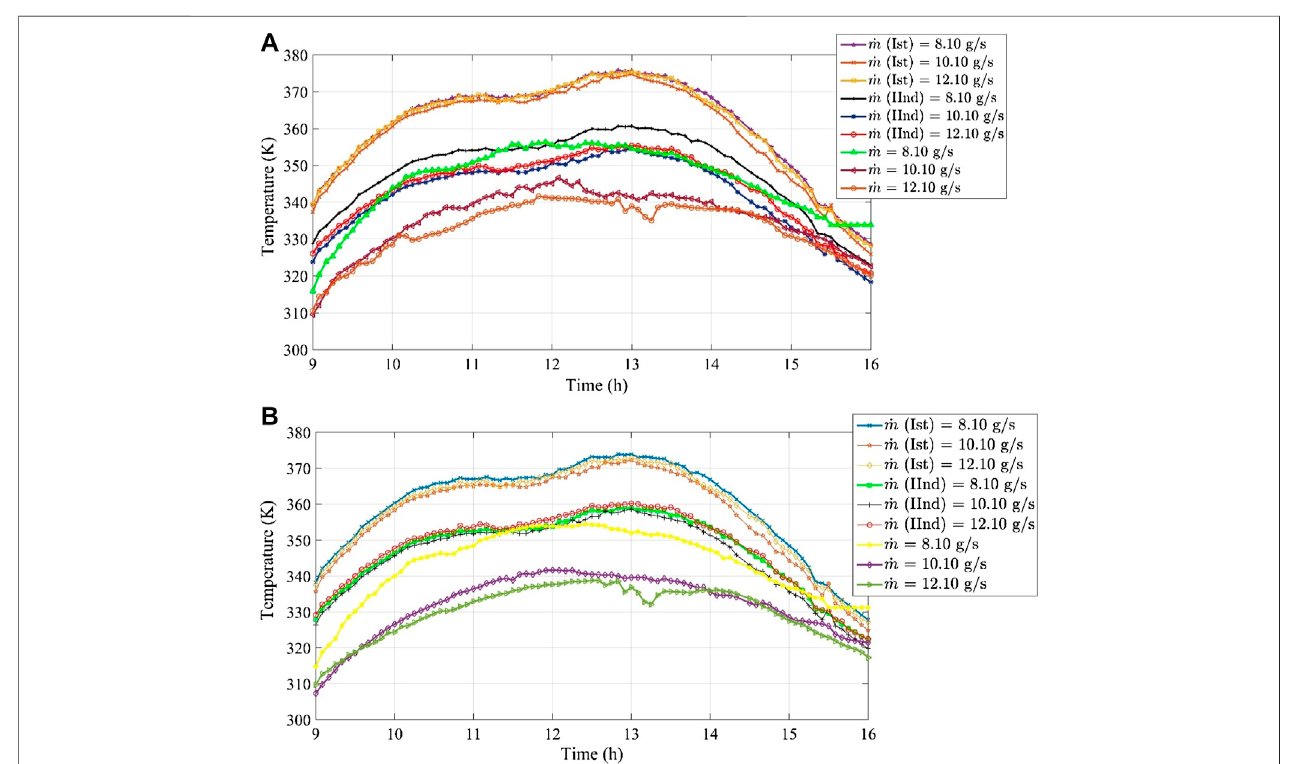
FIGURE 8 | The change in stagnant temperature ( T st ) of absorber plate with time. (A) Flat plate collector; (B) fl at plate collector with fi ns.